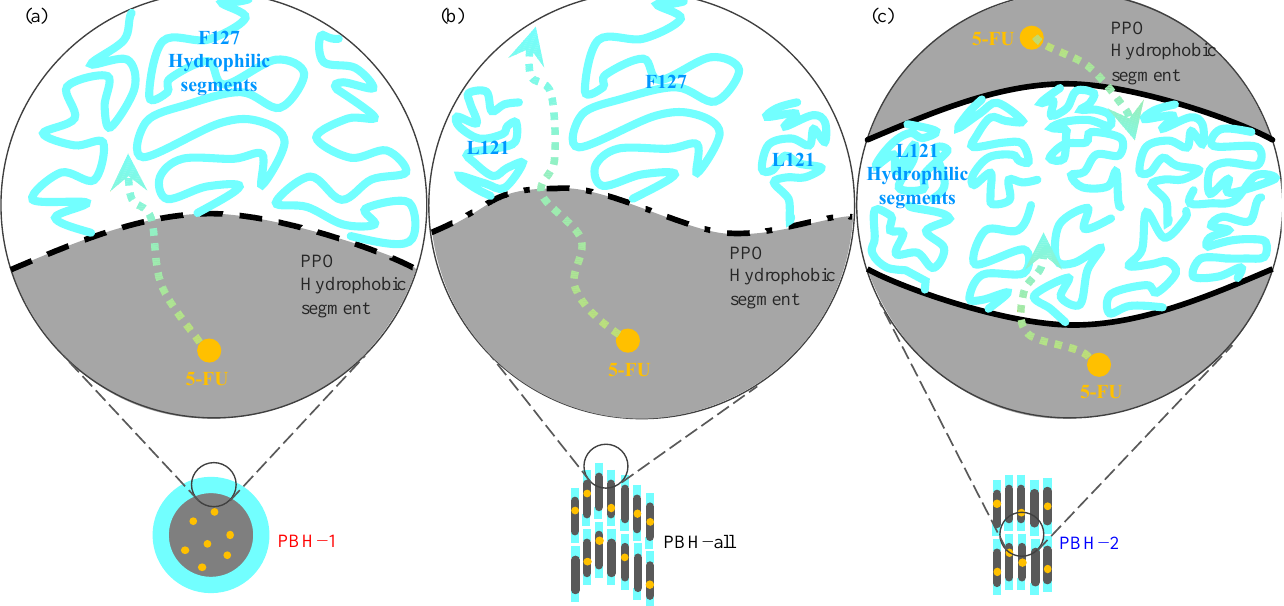
Figure 6. Microenvironment model of pluronic biomedical hydrogels. ( a ) PBH-1, ( b ) PBH-all, and ( c ) PBH-2.